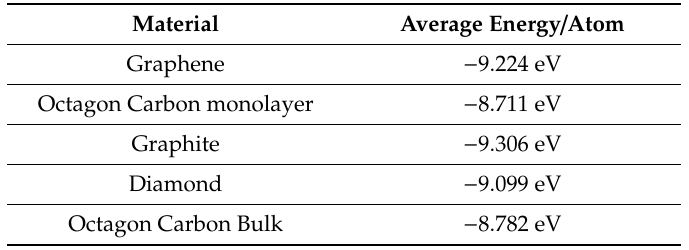
Figure 8. Raman spectra of the octagon ‐ structure carbon monolayer for three laser lines: 488 nm (green), 532 nm (blue) and 633 nm (red) with a Gaussian broadening width of 3 cm − 1 . ( a ) The incident light is from z ‐ axis. ( b ) The incident light is from x ‐ axis. Table 1. Free energy of graphene, graphite, diamond and octagon